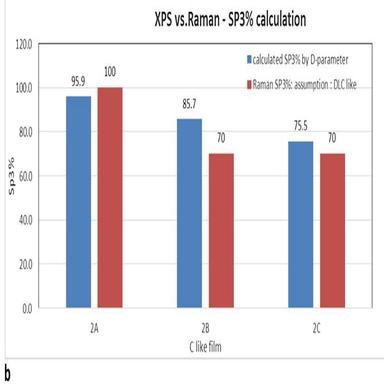
14a. Differentiated C KLL Auger from for Set 2 films; 14b. SP3% calculated in Set2 films by XPS and Raman.